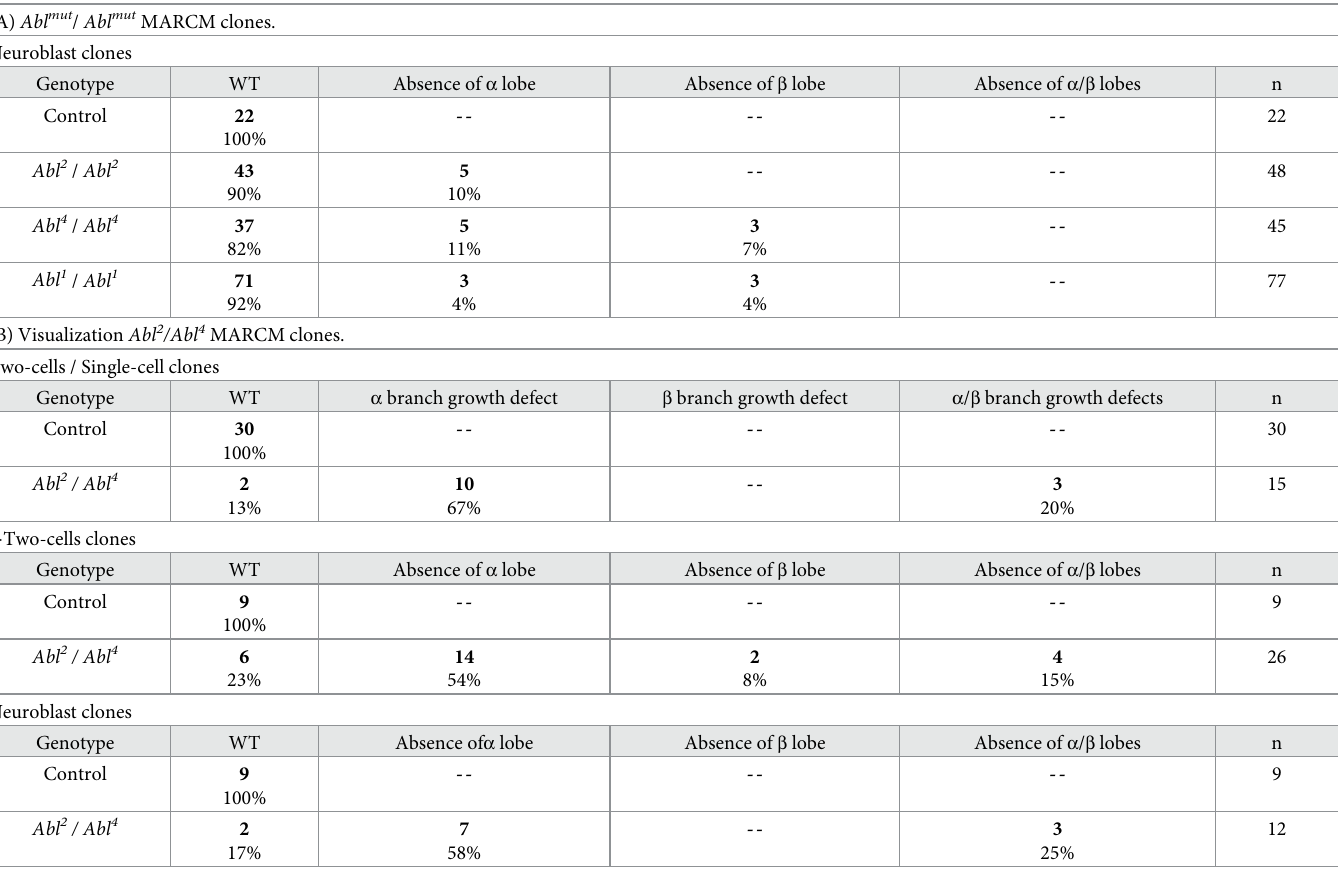
Table 1. Abl mutant MARCM clones. (A) Abl mut / Abl mut MARCM